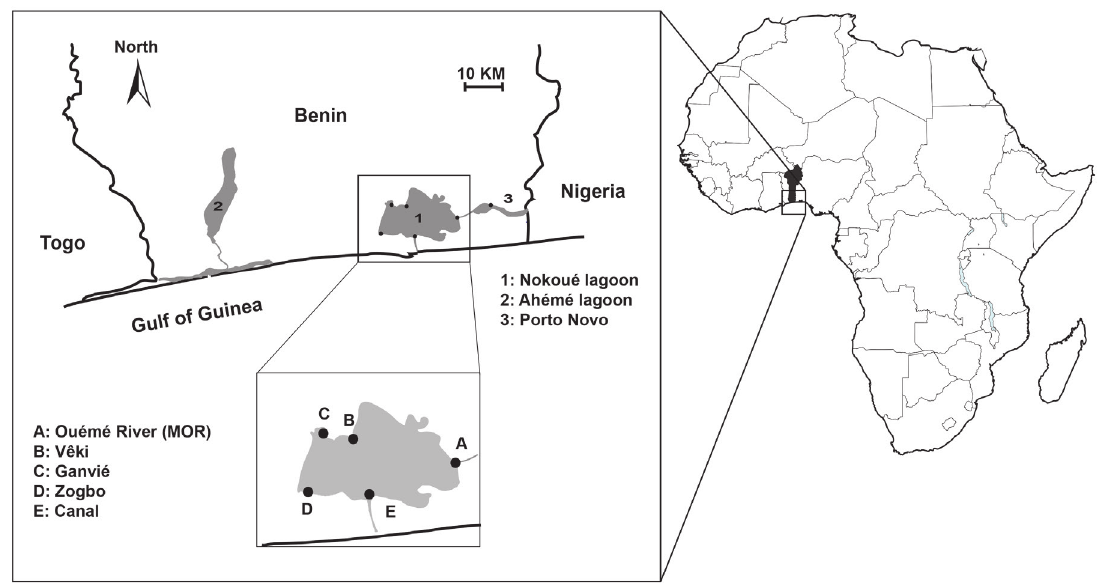
Fig. 1. Location of sampling sites in